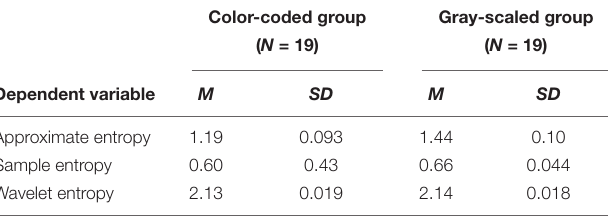
TABLE 5 | Means and standard deviations of spectral entropy variables. Color-coded group Gray-scaled